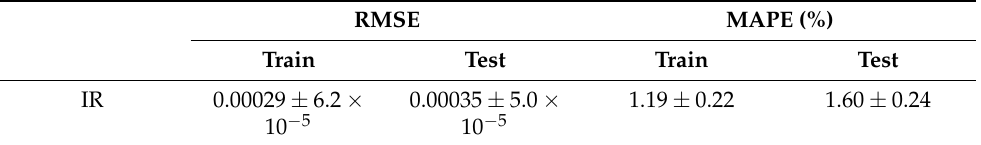
Table 2. Average performance of model to predict IR with 95% prediction intervals.